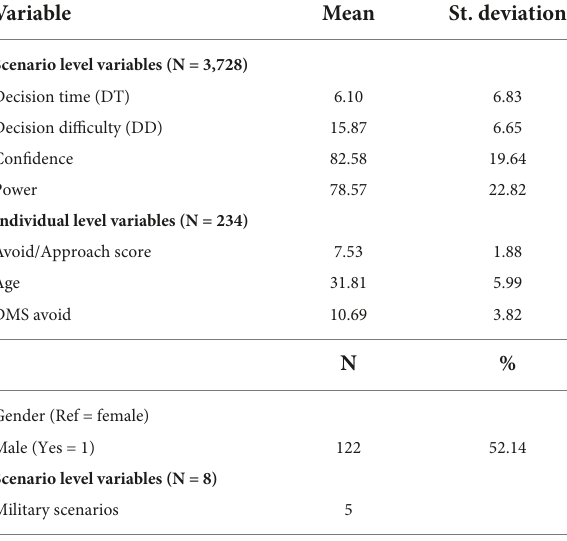
TABLE 5 Descriptive statistics for total sample.